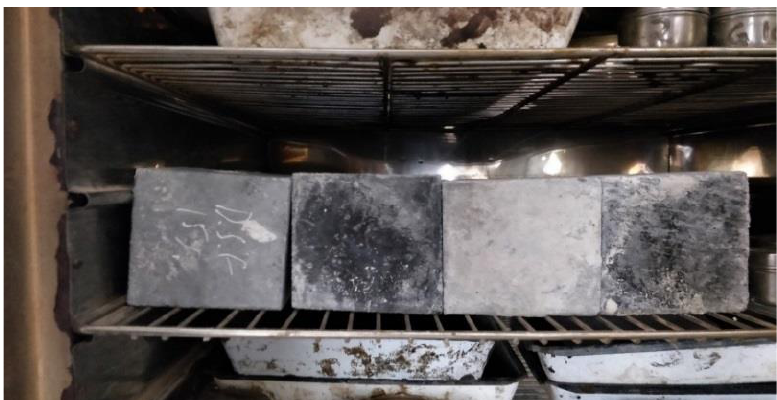
Fig. 27. Cubes placed in oven for desorption